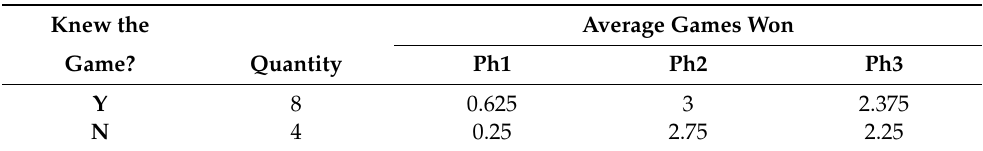
Table 5. Average games won by participant in each phase, dividing them into two differentiated groups depending on whether they knew or not the game. Knew the Average Games Won Game?